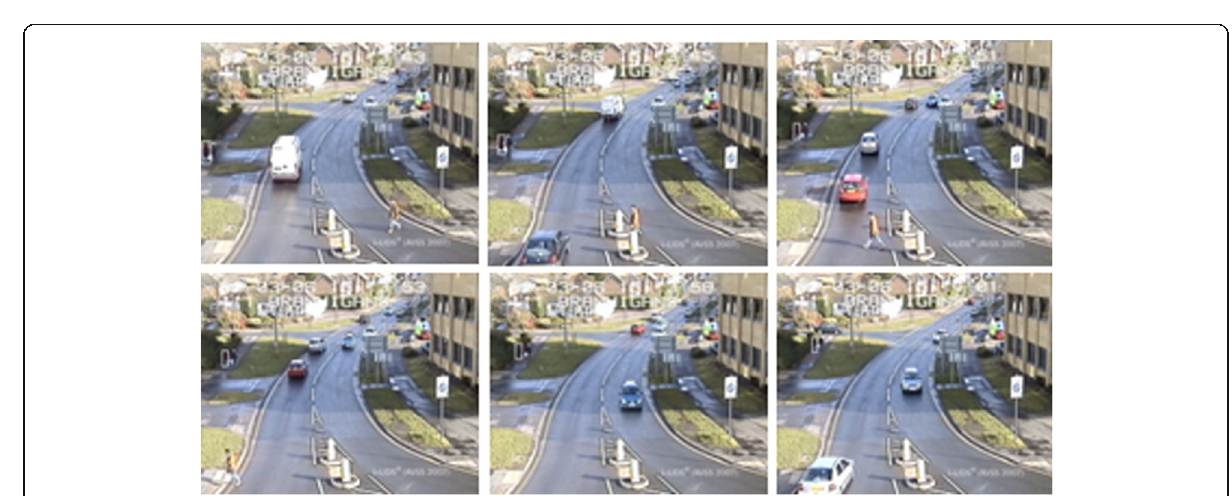
Fig. 16 Implementation results of proposed algorithm in person tracking from CAVIAR database set (images are from left to right)